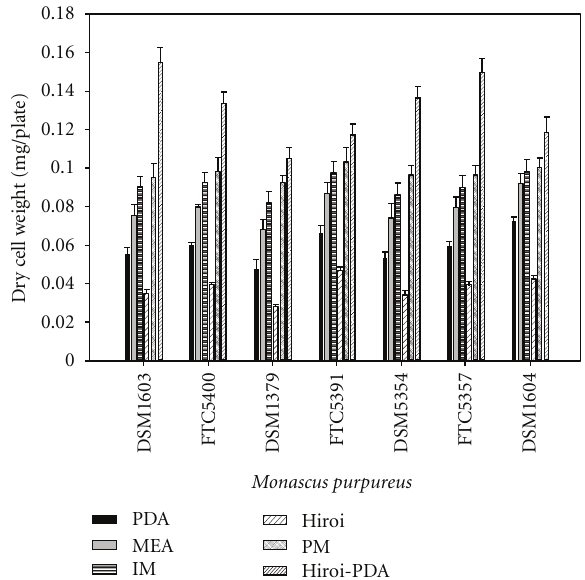
Figure 4: Comparison of cell production by di ff erent strains of Monascus spp cultivated on di ff erent solid media. Data are average of three determinations (mean ± SD).